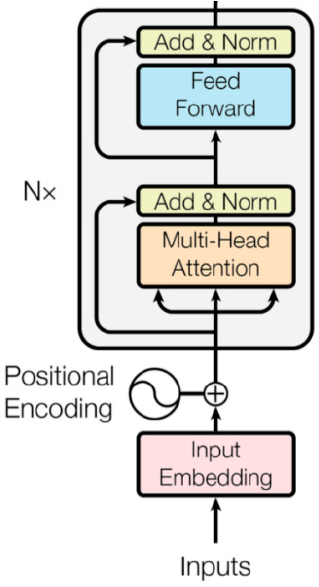
Figure 2. Framework diagram of transformer-encode.